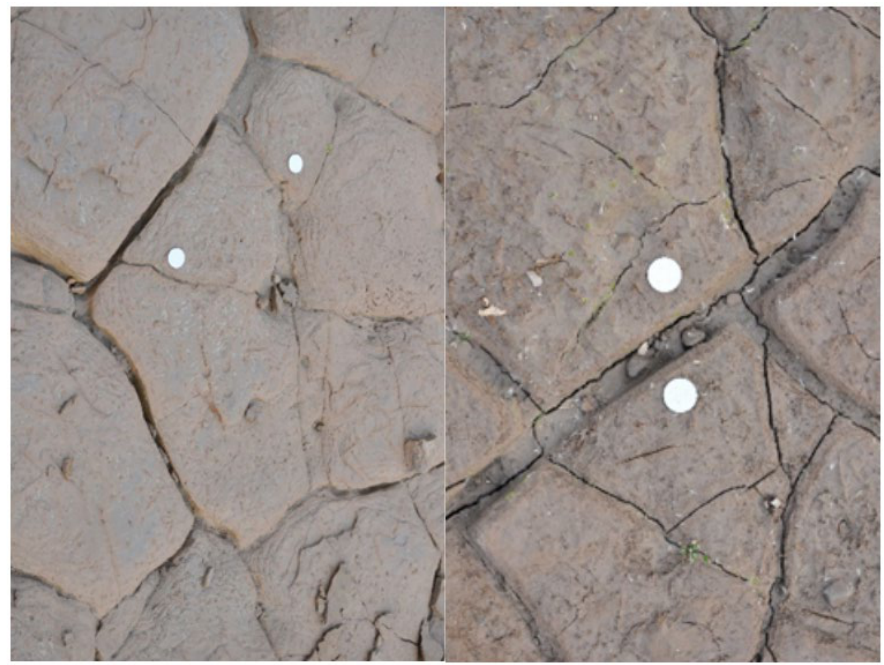
Figure 12. Mud fracture structure of floodplain near Zhengrunzhou.